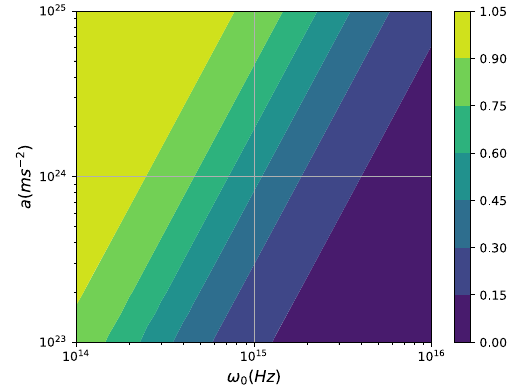
Fig. 1 Filled contours show the ratio of phase lag and frequency of oscillation due to EM field ( δη γ ). The distance between the atoms, L = 6 μ m , is chosen to be fixed. The acceleration ( a ) is varied from 10 23 –10 25 ms − 2 and the Zeeman frequency ( ω ◦ ) is varied from 10 14 – 10 16 Hz . We note that, for lower ω ◦ and higher a , the effect of the phase lag is strong, and in the other limit, for higher ω ◦ and lower a , the effect of the phase lag is vanishingly